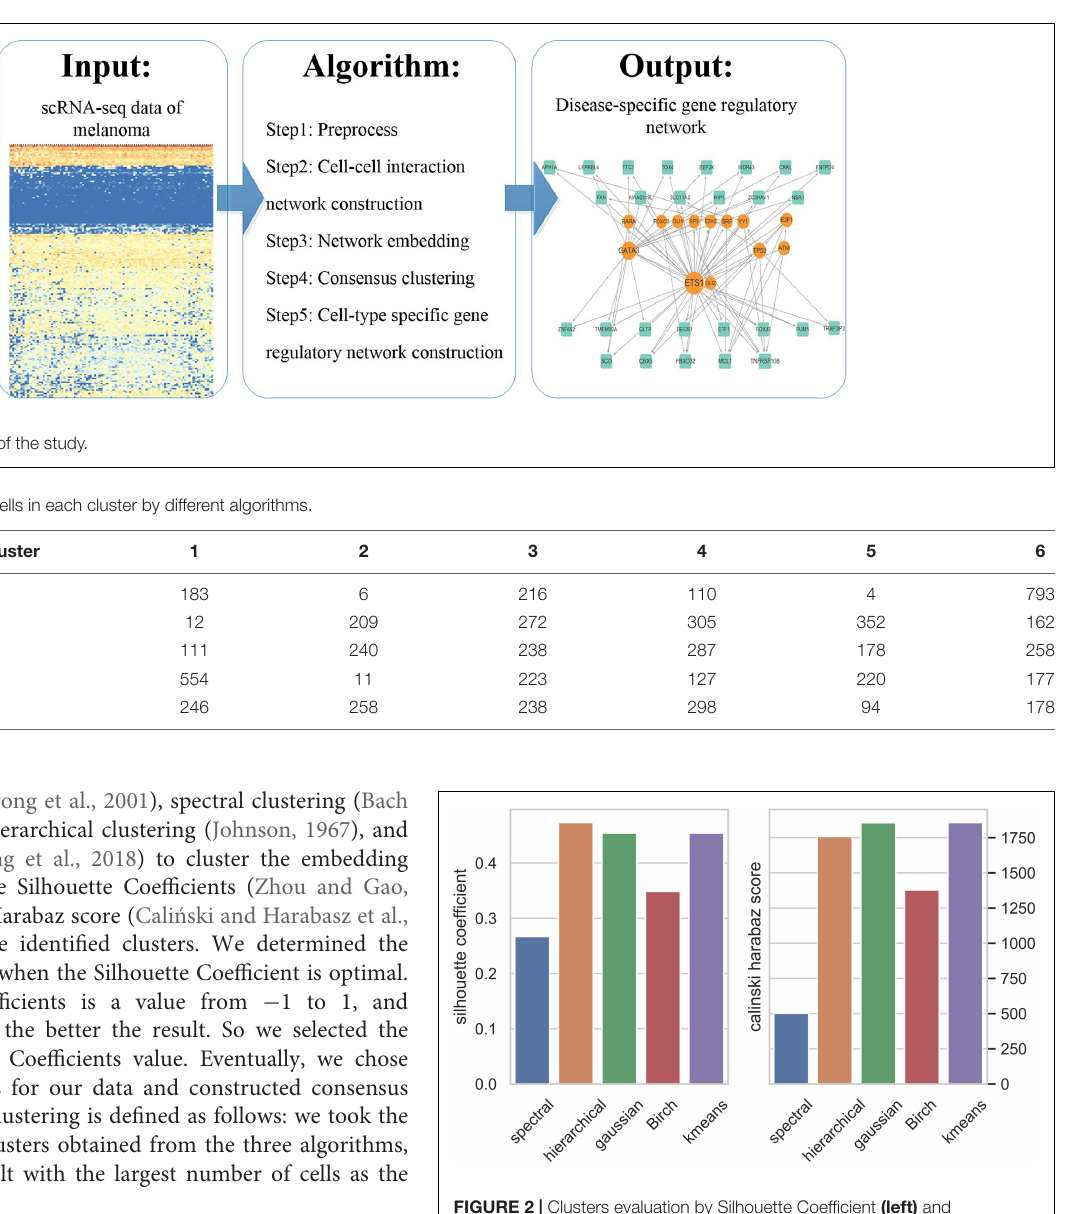
where dist ( g 1 , g 2 ) represents the Euclidean distance of the regulation pair ( g 1 , g 2 ) , and max ( dist ) and min ( dist ) represent the maximum distance and the minimum distance in all regulation pairs, respectively. The larger the value, the stronger the correlation between the genes. Then we identified the feed-forward loops (FFLs) (Jin, 2013) from these gene regulation pairs and constructed cluster specific gene regulatory networks by Cytoscape_v3.6.1 (Shannon et al., 2003). We took the top three genes with the highest degree from the specific gene regulatory network as hub